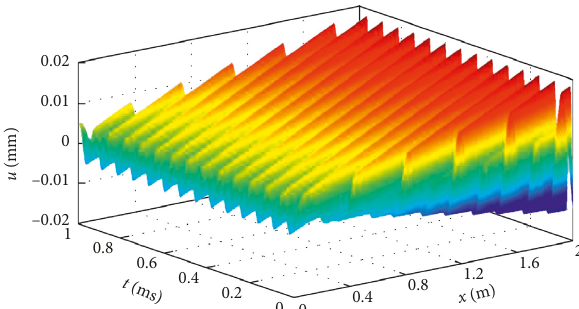
Figure 1: Approximate analytical solution to Equation (6). )